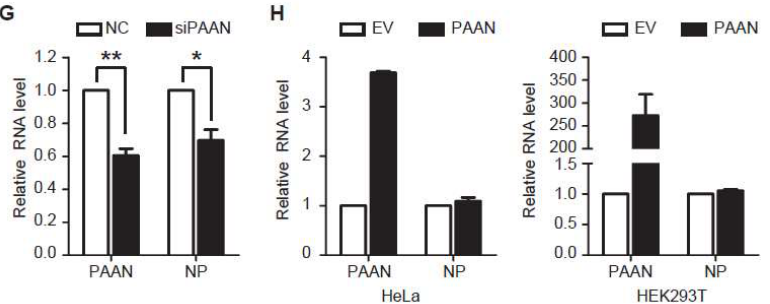
Figure 3. Downregulation of lncRNA-PAAN inhibits IAV replication. ( A – C ) HEK293T-Gluc cells were transfected with the indicated amounts of either esiPAAN or control esiEGFP for 48 h, followed by infection with IAV (MOI = 0.5) for 24 h. Levels of lncRNA-PAAN were quantified by qRT-PCR and GAPDH mRNA levels were used to normalize the levels of lncRNA-PAAN ( A ). Viral infectivity was determined by measuring Gluc activity ( B ) and infectious titers of progeny IAV in supernatants were determined by performing the TCID50 assay (shown in ( C )); ( A – C ) data are normalized to control group, with the value of control arbitrarily set as 1; ( D ) HEK293T cells were transfected with the indicated amounts of esiPAAN or esiEGFP for 48 h. Cell viability was determined by performing the CCK8 assay; ( E ) A549 cells were transfected with either esiPAAN or control esiEGFP (40 nM) for 24 h, followed by infection with IAV (MOI = 0.5) for 36 h. Levels of lncRNA-PAAN and viral RNA were determined by qRT-PCR; ( F ) HEK293T cells were transfected with either esiPAAN or control esiEGFP (20 nM) for 36 h, followed by infection with A/PR/8/34(H1N1) or A/Beijing/30/95(H3N2) (MOI = 0.5) for 24 h. Levels of PAAN RNA and viral RNA were determined by qRT-PCR; ( G ) HEK293T cells were transfected with either siPAAN or negative control siRNA (50 nM) for 36 h, followed by infection with IAV (MOI = 0.5) for 24 h. Levels of PAAN RNA and viral RNA were determined by qRT-PCR; ( H ) HeLa and HEK293T cells were transfected with plasmid DNA expressing lncRNA-PAAN or empty vector (EV) for 24 h and infected with IAV (MOI = 0.5) for 36 h. The levels of lncRNA-PAAN and viral RNA were quantified by qRT-PCR; In ( E – H ) data, the level of GAPDH mRNA was also determined and used as the internal control to normalize the level of lncRNA-PAAN, and results are normalized to the values of the control, with the value of the control arbitrarily set as 1. IAV means the WSN strain unless otherwise specified. *: p ≤ 0.05; **: p ≤ 0.01.